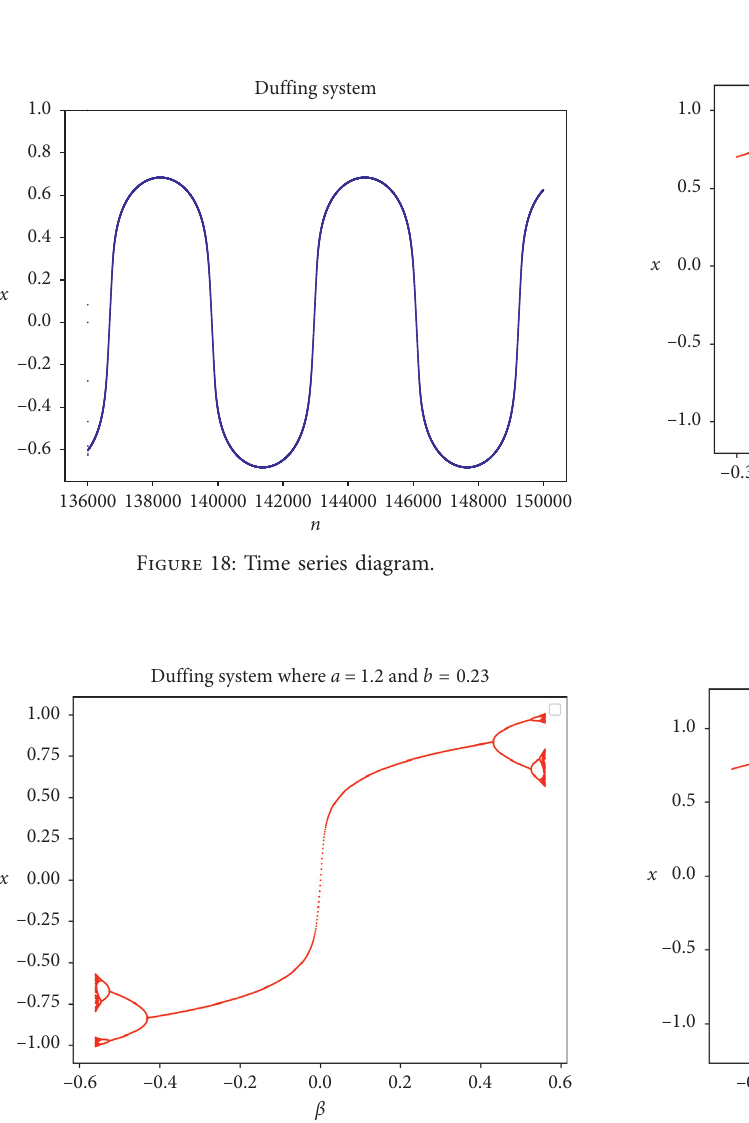
Figure 19: Bifurcation diagram of β .